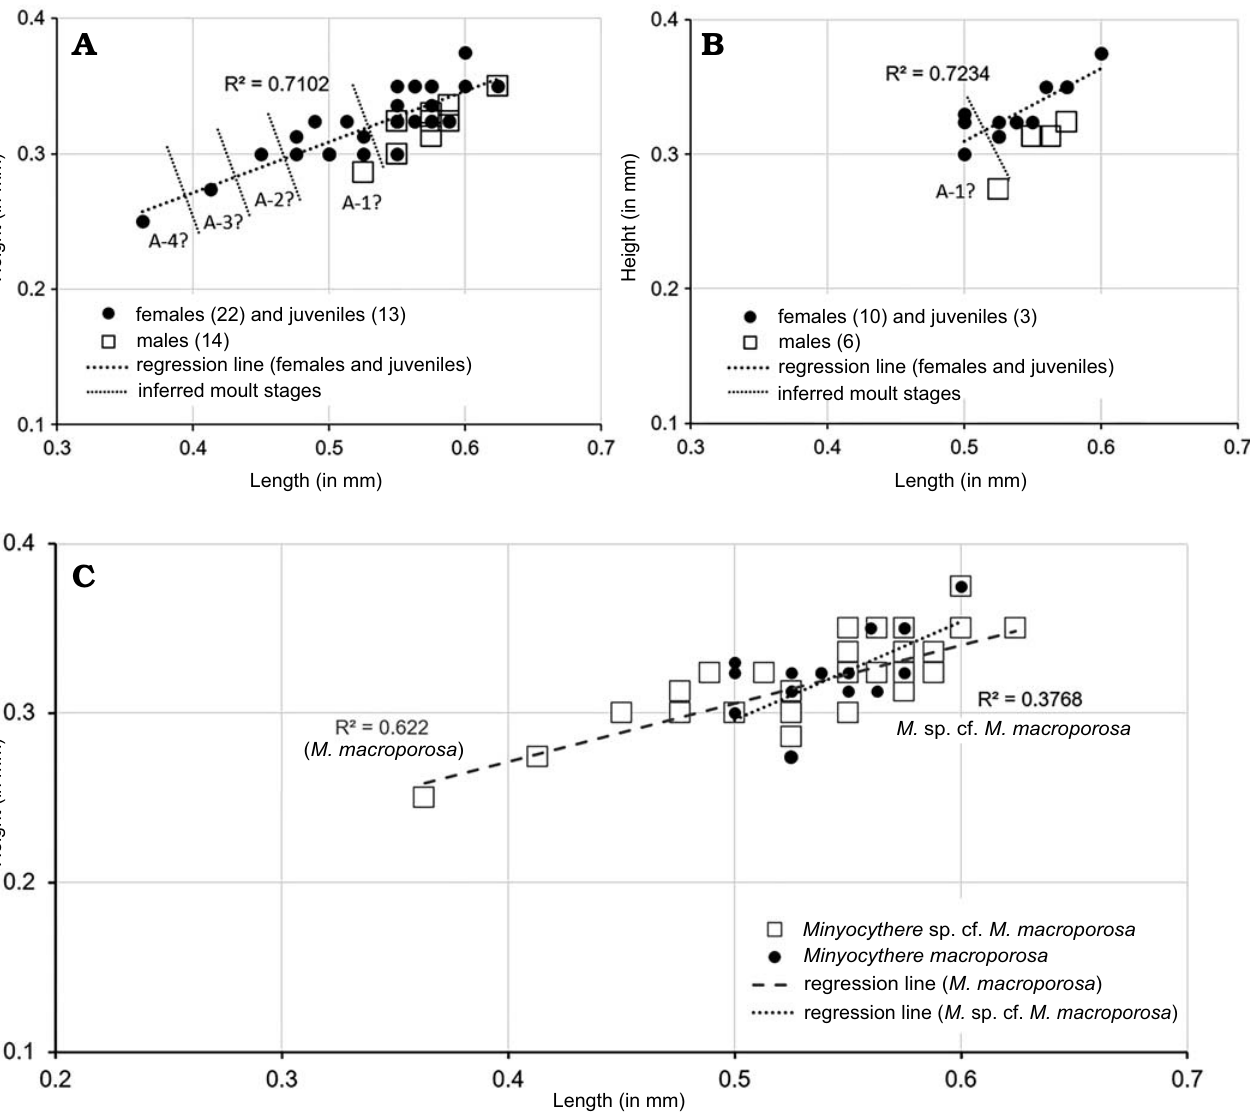
Fig. 8. Length versus height plots for Minyocythere macroporosa sp. nov. ( A ) and Minyocythere sp. cf. M . macroporosa sp. nov. ( B ), comparison ( C ). A-1–A-4, estimated growth (moult)